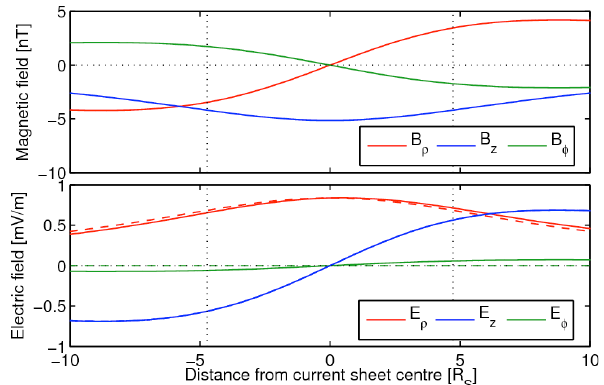
lines around a current sheet in the z=0 plane. The (z, ρ ) coordinates indicate a convenient 394 “sheet coordinate system”. Panel (a) shows the sheet moving upwards, (b) the sheet at rest, 395 (c) the sheet moving downwards. In each case Titan (the grey circle) may be located above 396 the sheet, near the centre of the sheet, or below the sheet. For example, the bottom circle in 397